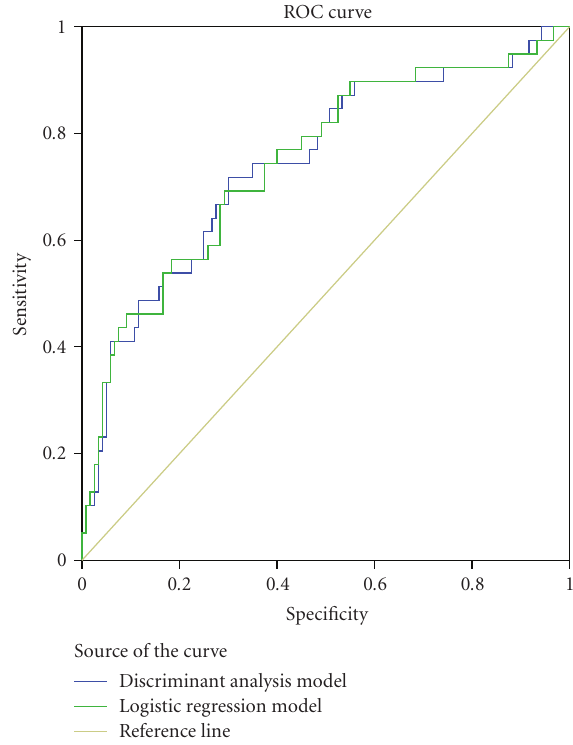
Figure 1: Receiver operating characteristics (ROC) curves for the discriminant analysis and logistic regression